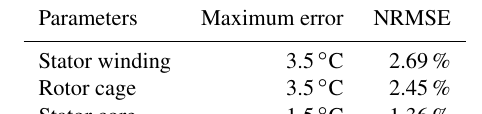
Table 4. Error and NRMSE of the estimated temperatures under S6. Parameters